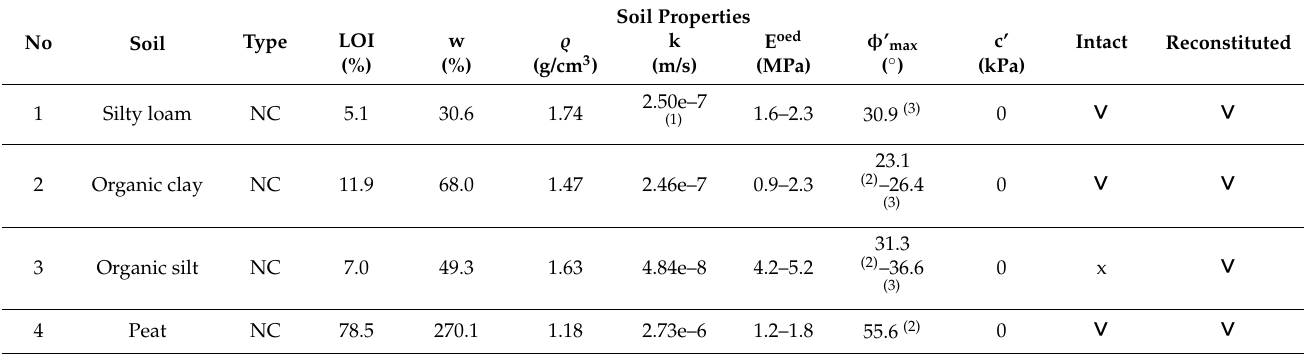
Table 3. Geotechnical parameters of soils used in interface testing.